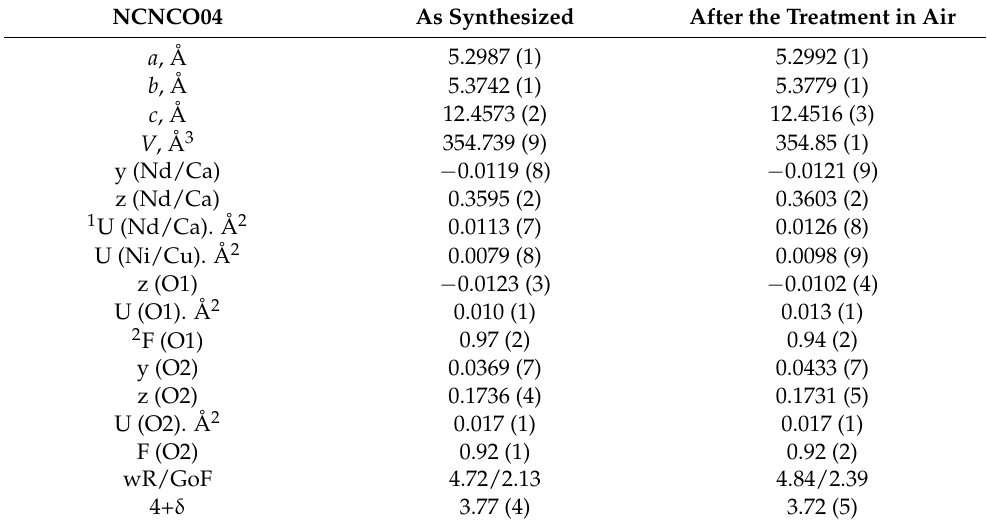
Table 3. Results of the Rietveld refinement of the NCNCO04 structure obtained at 50 ◦ C by TOF NPD. NCNCO04 As Synthesized After the Treatment in Air a ,